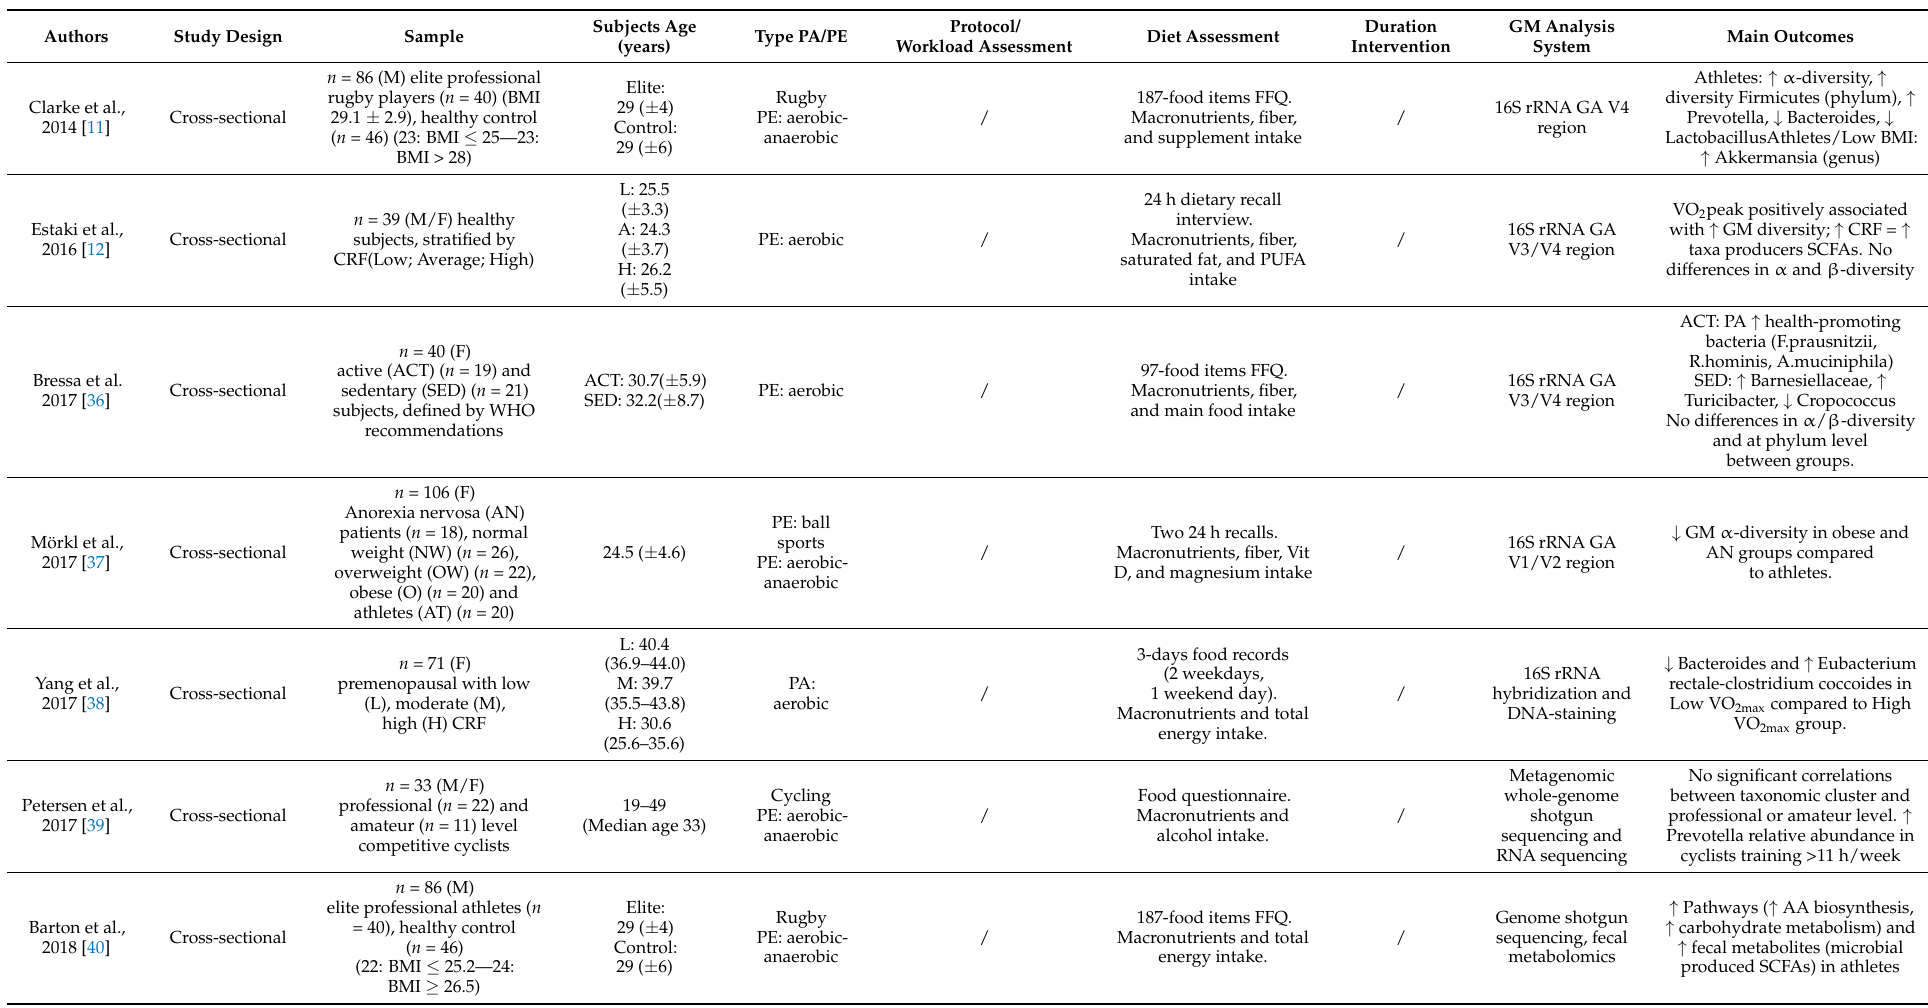
Table 5. Summary characteristics of reviewed